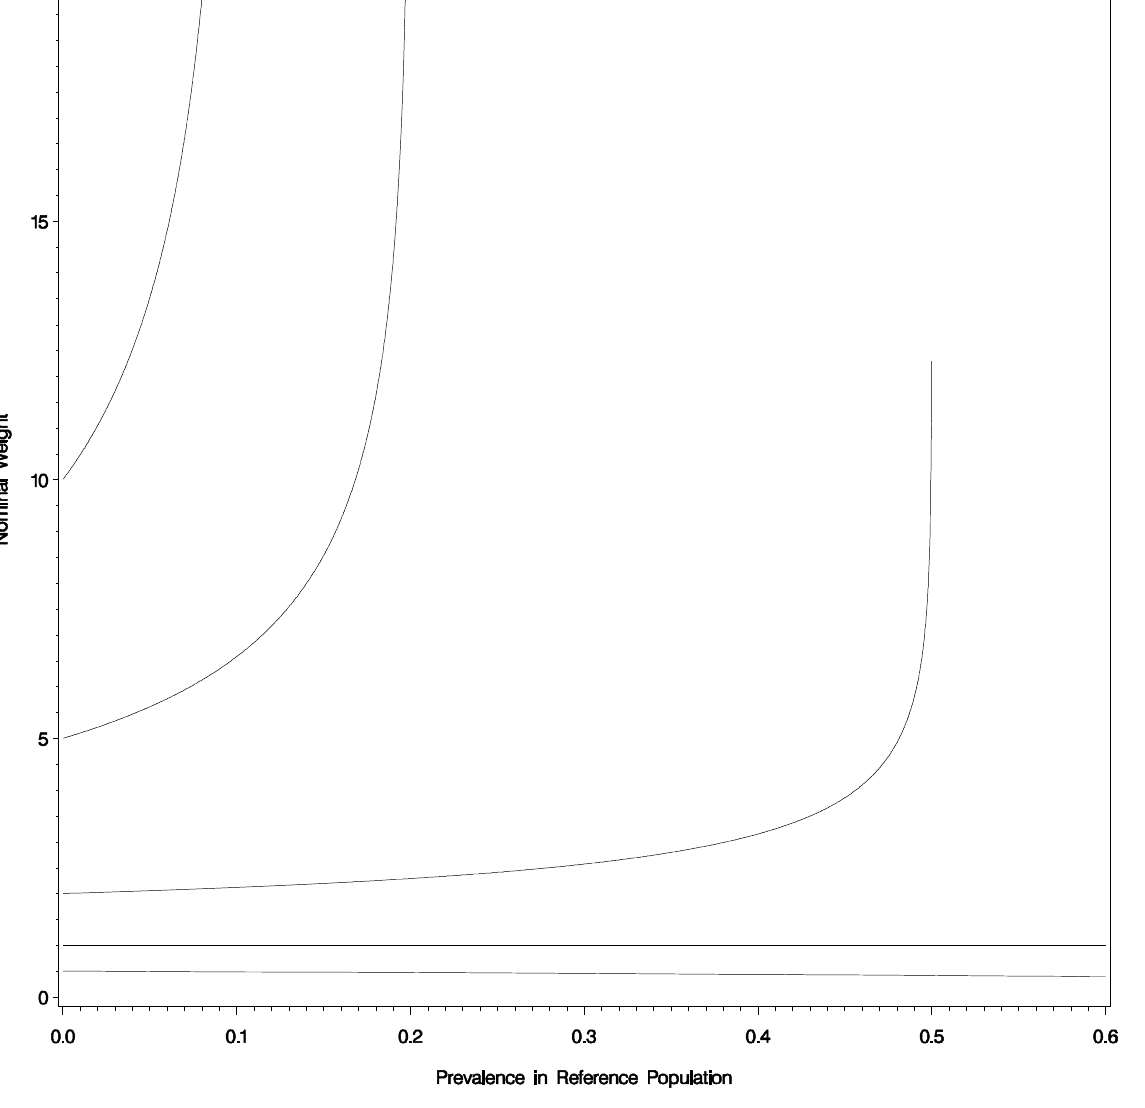
Figure 1. Nominal weights as a function of the prevalence ratio p 1 = p 0 and prevalence p 0 . Nominal weights are shown for 5 fixed prevalence ratios: 10, 5, 2, 1, and 0.5, which are in ascending order in the figure. The x-axis is the denominator prevalence p 0 . Nominal weights increase rapidly as the numerator prevalence p 1 approaches 1; as the numerator class becomes more like a ‘‘perfect sentinel’’.